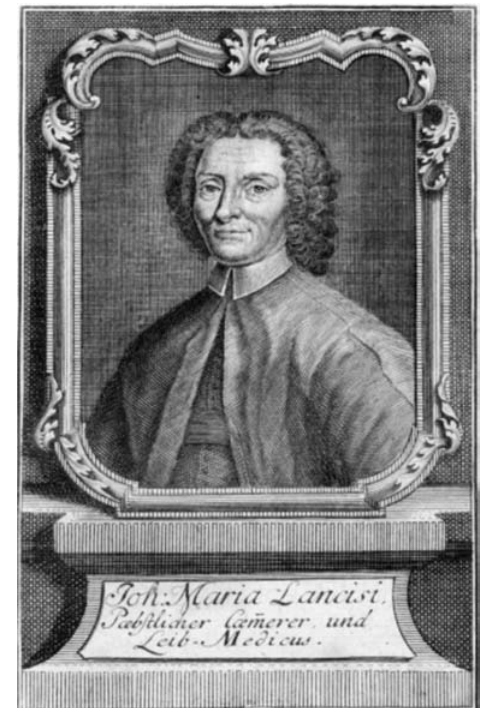
Figure 1. Giovanni Maria Lancisi (1654–1720), an Italian physician, epidemiologist and anatomist. He observed marked neck venous distension with tricuspid valve insufficiency (later to be known as Lancisi’s sign)